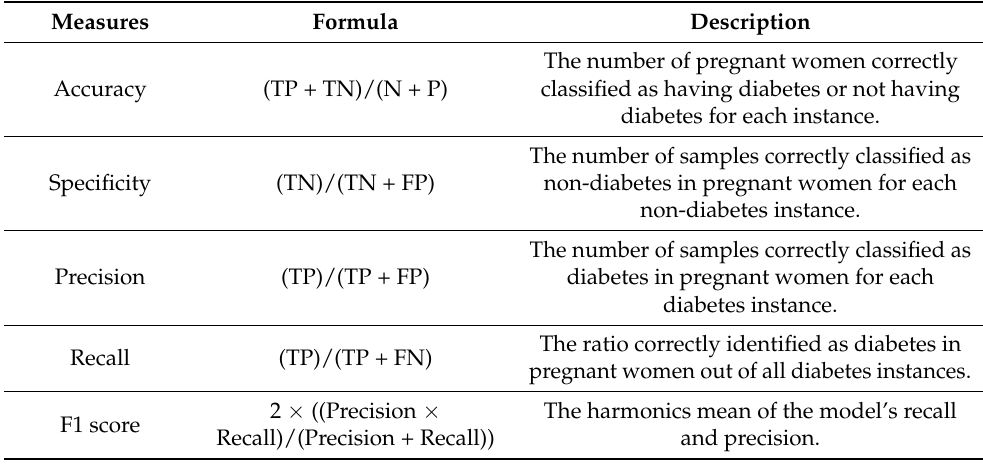
Table 8. Evaluation metrics definition and the